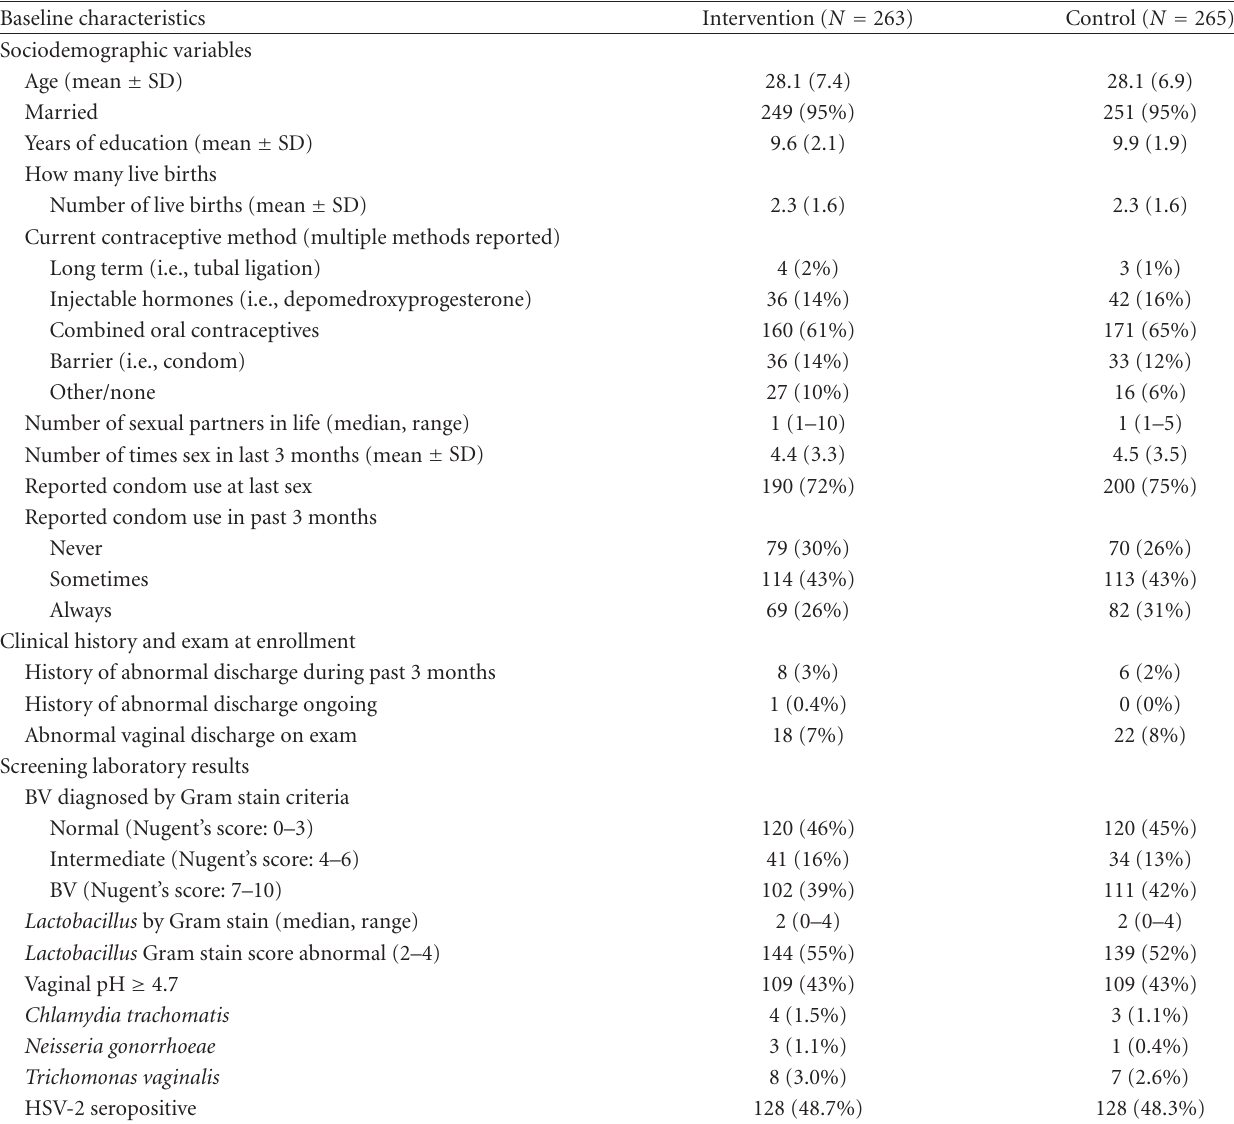
Table 1: Baseline demographics, clinical and exam findings, and initial laboratory findings for trial participants by group assignment.